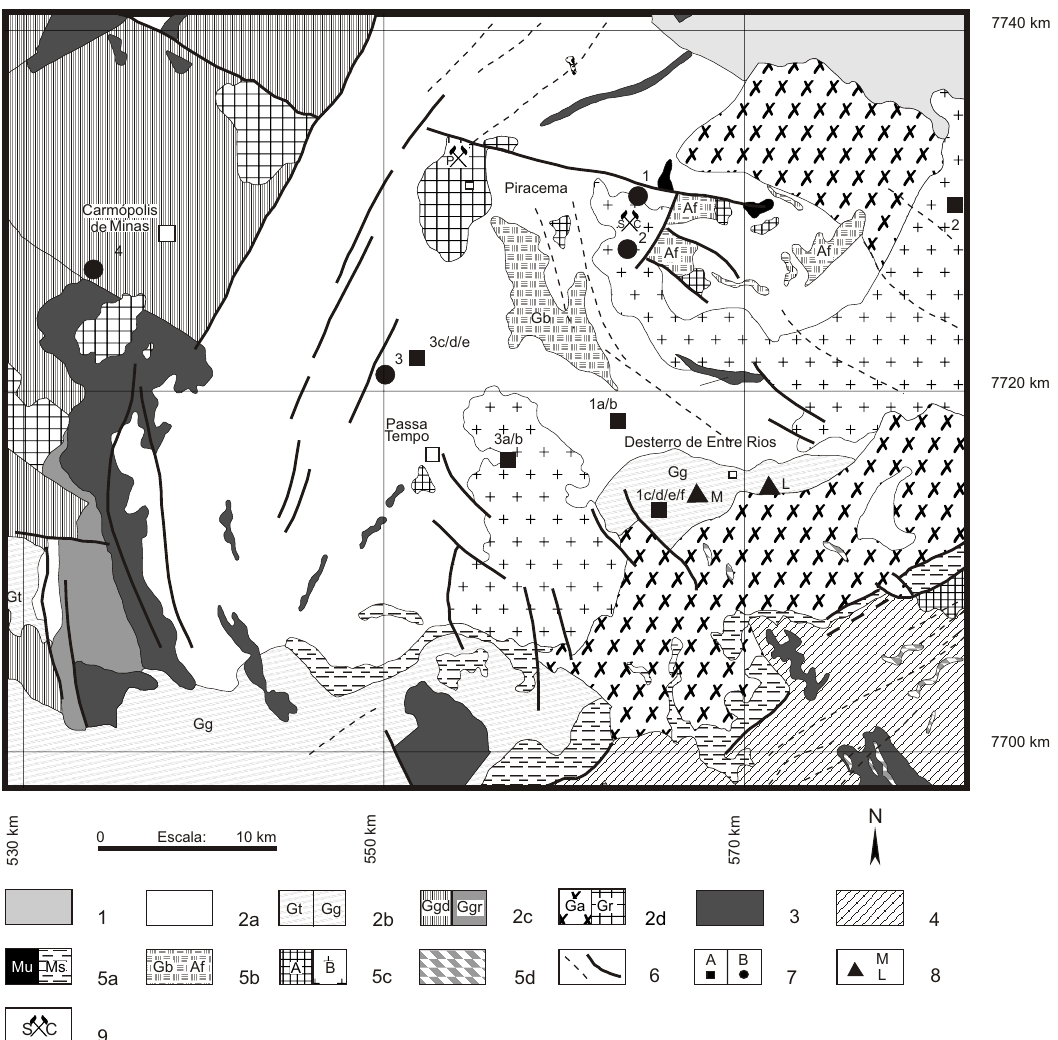
Fig. 2 – Detailed geologic map of the Passa Tempo region (modified after Perillo 2000). Key: 1 – Bonfim Metamorphic Complex; 2 – Passa Tempo Metamorphic Complex [2a – tonalitic-trondhjemitic to granitic gneisses of the granulite facies, 2b – tonalitic (Gt) and granitic(Gg)orthogneisses, 2c–migmatizedorthogneisseswithgranodioritic(Ggd)orgranitic(Ggr)mesosome, 2d–anatecticgranites (Ga) and rosy granites (Gr)]; 3 – Rio dasVelhas Supergroup; 4 – Paleoproterozoic Granites; 5 – Lithodemic units of uncertain age [5a – meta-ultrabasic (Mu) and metasedimentary (Ms) rocks: quartzites, ferruginous quartzites, itabirites, quartz-muscovite schists, altered purple schists, 5b – gabbros (Gb) and amphibolites (Af), 5c – somewhat deformed, light-gray granodiorites (A) and variably-deformed, porphyroid, light-gray granites (B), 5d – pegmatites]; 6 – Shear Zones, dashed where less prominent; 7 – Sampled points dated by Rb-Sr (A) and K-Ar (B) geochronologic methods (Fiumari et al. 1985, Teixeira 1985); 8 – Location of the samples dated in this work (M = mesosome, L = leucosome); 9 – Quarry location (P = Piracema; SC = Serra dos